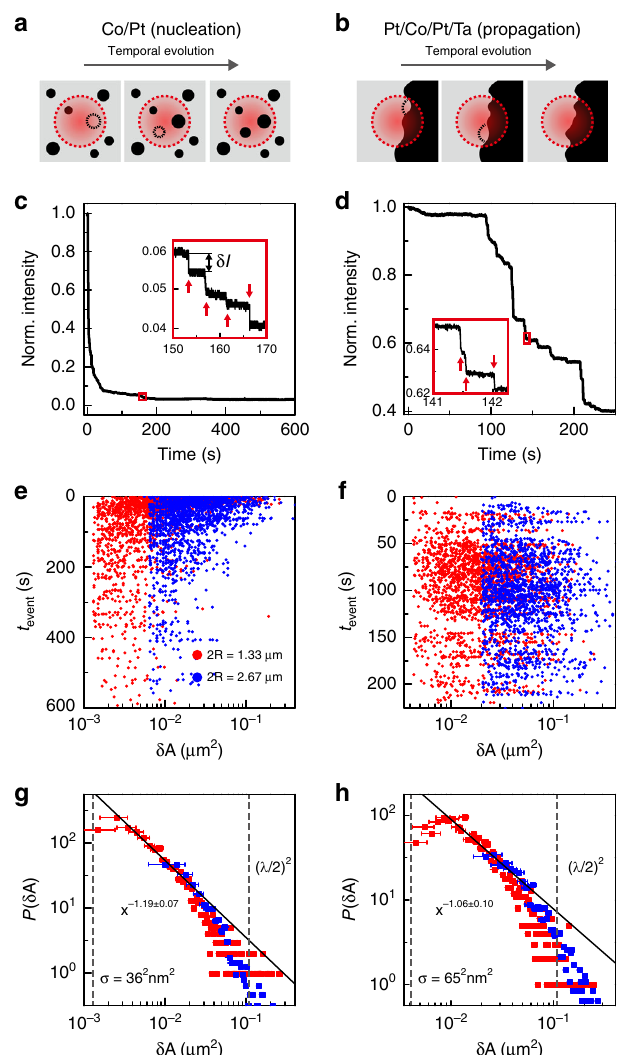
Fig. 4 Barkhausen jumps beyond the diffraction limit. a , b Barkhausen jumps, the magnetisation reversals of individual coherent magnetic domains, cause abrupt changes of the MOKE intensity. The dotted red circle indicates the area of detection. The a Co/Pt and b Pt/Co/Pt/Ta fi lms exhibit reverse domain nucleation and domain wall propagation, respectively. c , d Real-time measurements of magnetisation reversals of the c EAR Co/Pt and d EAR Pt/ Co/Pt/Ta fi lms. As shown in the magni fi ed plots (insets), the Barkhausen jumps far below the wavelength scale (red arrows) are successfully resolved in terms of the MOKE intensity change ( δ I ). e , f Temporal statistics of the Barkhausen jumps depending on the size ( δ A ) in the EAR Co/Pt ( e ) and EAR Pt/Co/Pt/Ta ( f ) fi lms, respectively. The measurements with different diameters of the region of interest ( 2R ) of 1.33 μ m and 2.67 μ m are plotted by the red and blue dots, respectively. g , h Distribution of the Barkhausen size ( δ A ) in EAR Co/Pt ( g ) and EAR Pt/Co/Pt/Ta ( h ), respectively. The scale-invariant Barkhausen jump events are fi tted by a power law for the domain size (solid line). The vertical dashed lines indicate the minimal size of measurable domains ( σ ) and the optical diffraction limit (( λ /2) 2 ). The error bars represent the signal detection resolution of the measurement setup (Methods and Supplementary Note